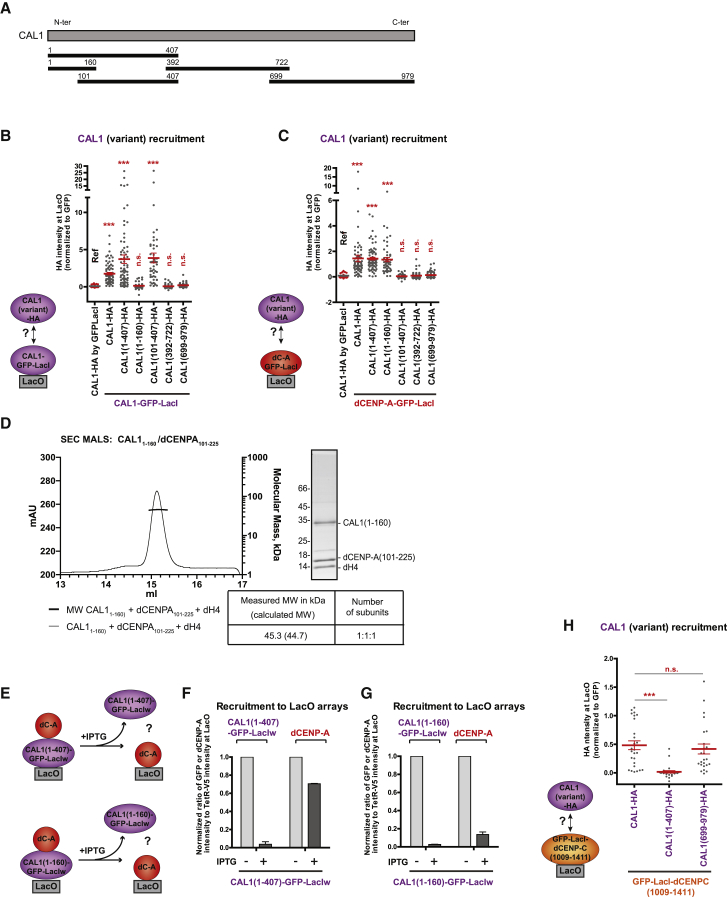
Self-Association of CAL1 Is Not Required for Its Interaction with dCENP-A and dCENP-C but Is Essential for Loading dCENP-A into Chromatin(A) The CAL1 N-terminal, middle, and C-terminal regions used in this study are represented by black horizontal lines with numbers indicating amino-acid positions.(B and C) Experimental schemes and quantitation of normalized HA-tagged CAL1 and CAL1 fragment mean intensities at LacO upon tethering of CAL1-GFP-LacI (B), dCENP-A-GFP-LacI (C), or GFP-LacI (B and C, first lane).(D) SEC-MALS experiments performed with recombinant CAL1(1-160) in complex with dCENP-A(101-225) and dH4. Elution volume (ml, x axis) is plotted against absorption at 280 nm (mAu, left y axis) and molecular mass (kDa, right y axis). Tables show measure molecular weight (MW) and calculated MW. Mw/Mn = 1.001.(E) Experimental scheme for the experiments shown in (F) and (G).(F and G) Quantitation of normalized dCENP-A, CAL1(1-407)-GFP-LacIw (F), and CAL1(1-160)-GFP-LacIw (G) mean intensities at LacO, +/− IPTG treatment.(H) Quantitation of normalized HA-tagged CAL1 and CAL1 fragment mean intensities at LacO upon tethering of GFP-LacI-CENP-C(1009-1411).Error bars show SEM (∗∗∗p < 0.001; n.s., not significant). The reference sample for statistical analysis is indicated as Ref.See also Figures S3 and S4.